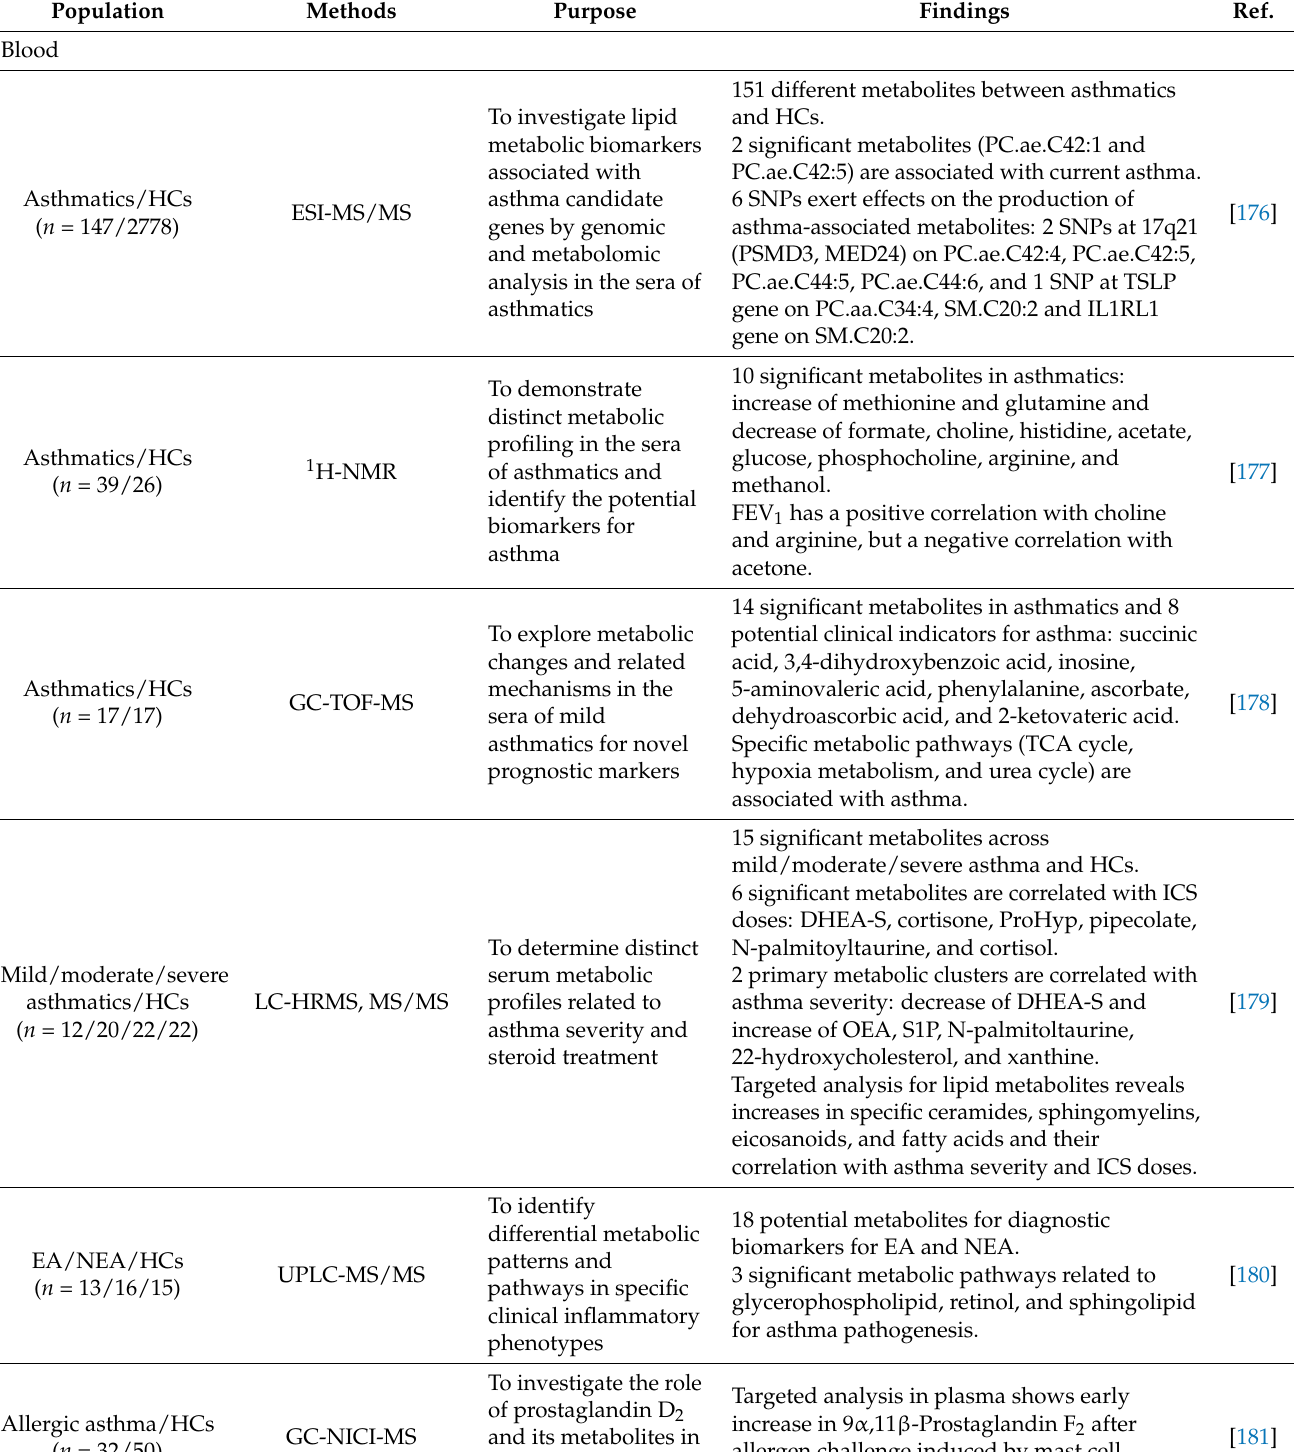
Table 4. Summary of metabolomic analyses in adult